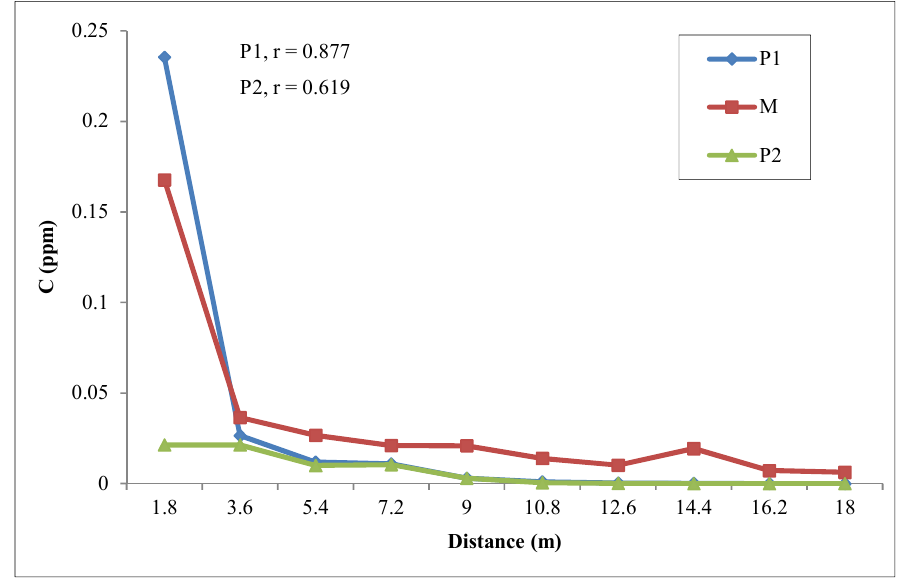
Figure 14. Measured and Predicted Concentrations against Distance for the month of